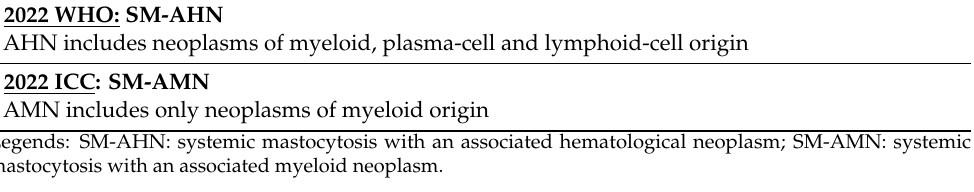
Table 4. Hematological malignancies associated with SM according to 2022 WHO and 2022